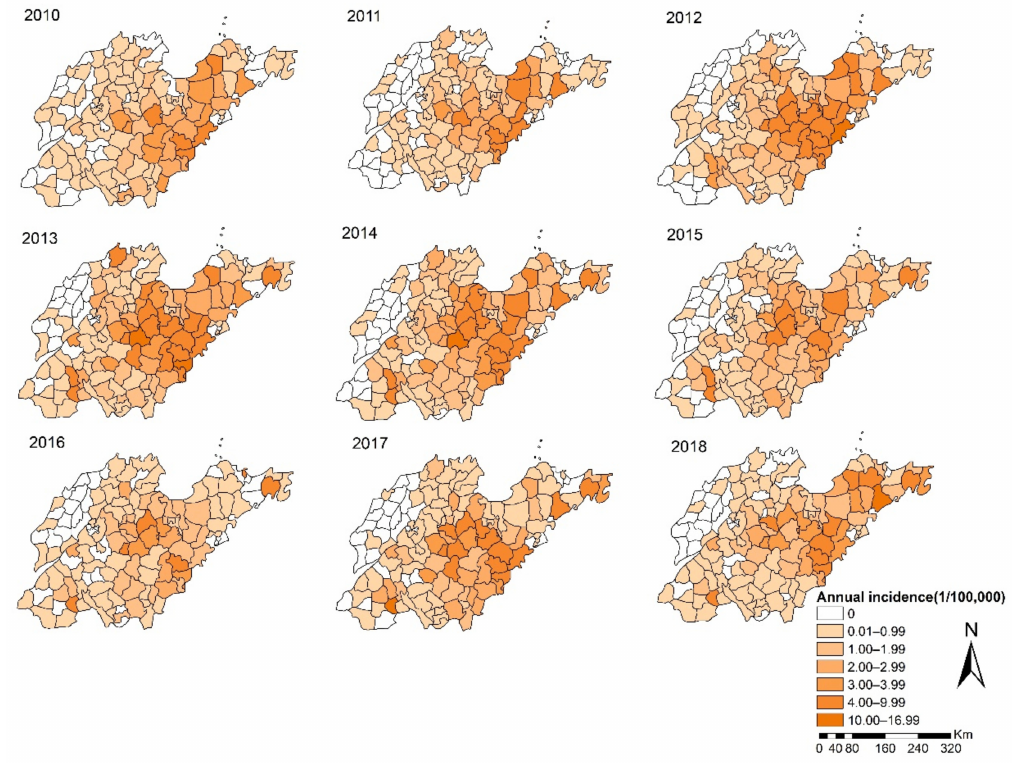
Figure 3. The spatial distribution of HFRS incidence in Shandong Province from 2010 to